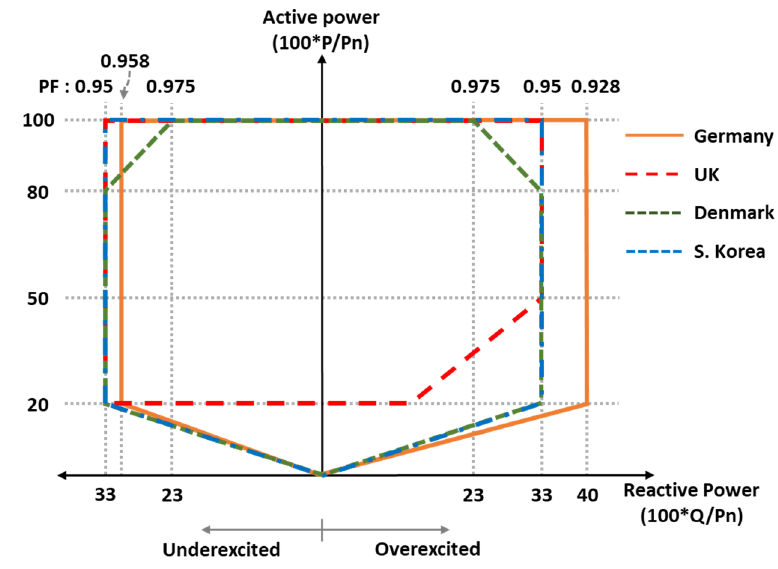
Figure 1. Reactive power capability requirements in various grid codes [7–10].